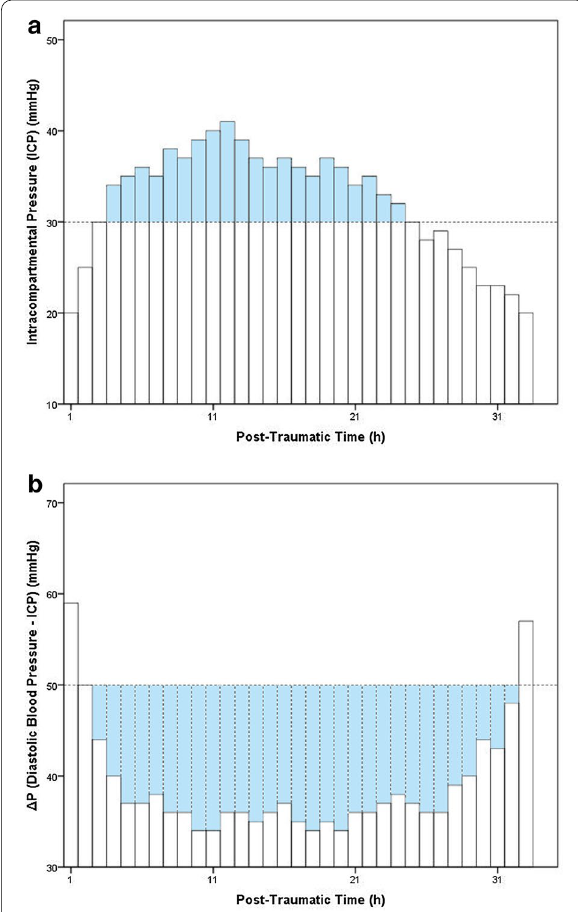
Fig. 3 a Accumulated ICP: the sum of the hourly ICP values exceeding 30 mmHg. b Accumulated Δ P : the sum of the hourly Δ P values below 50